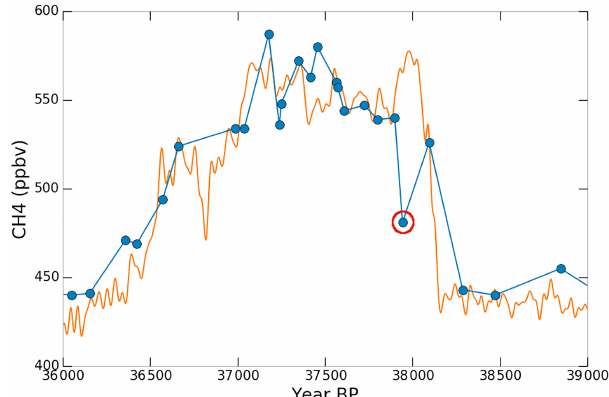
Figure 7. Discrete EDC methane record (blue) and continuous WDC methane record (orange). The WDC record was put on the GICC05 timescale and then shifted by 250 years to improve match- ing. We suggest that the circled point corresponds to a layered trap- ping